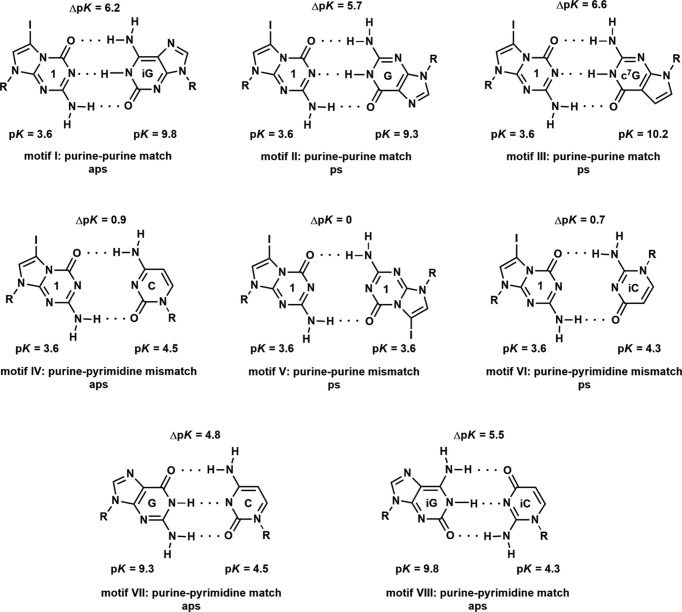
Base-pairing motifs of 5-aza-7-de­aza­guanine nucleosides, pKa values of the base-pairing nucleosides and their pK value difference (ΔpK), as well as strand orientation of the respective duplex. Notes: R = β-d-ribo­furanosyl, C = cytidine, iG = isoguanosine, iC = isocytidine, G = guanosine, c7G = 7-de­aza­guanosine, aps = anti­parallel strands and ps = parallel strands.